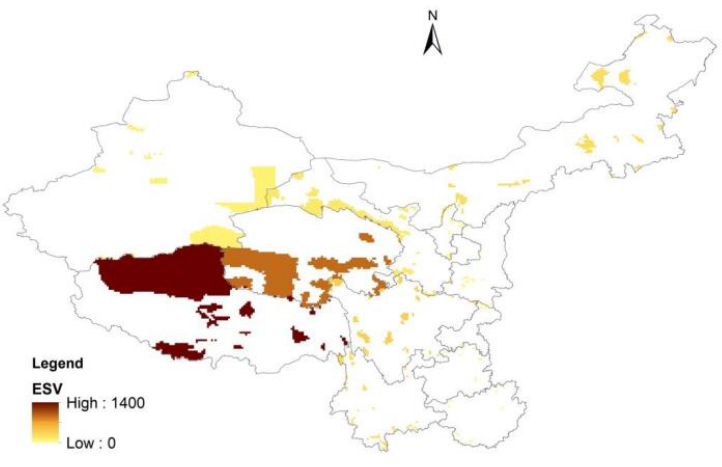
Figure 9. Ecosystem services values in the national nature reserves of western China in 2000.